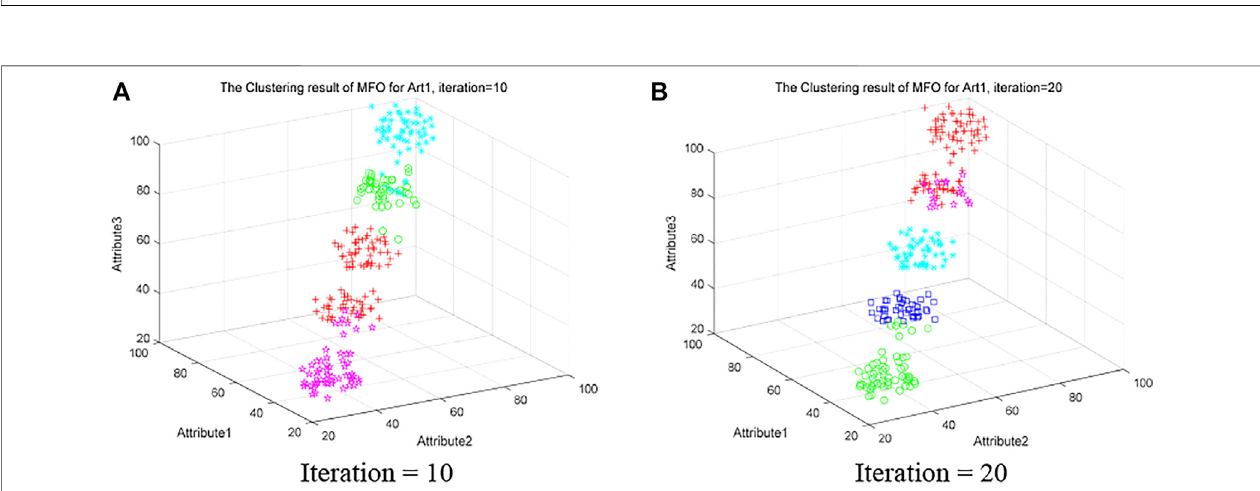
FIGURE 8 | Clustering results of MFO on the Art 1 dataset at iteration is 10 and 20. (A) Iteration = 10. (B) Iteration = 20.